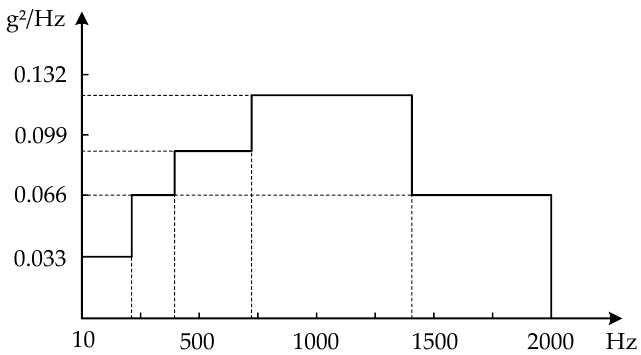
Figure 6. Load spectrum curve of random excitation.